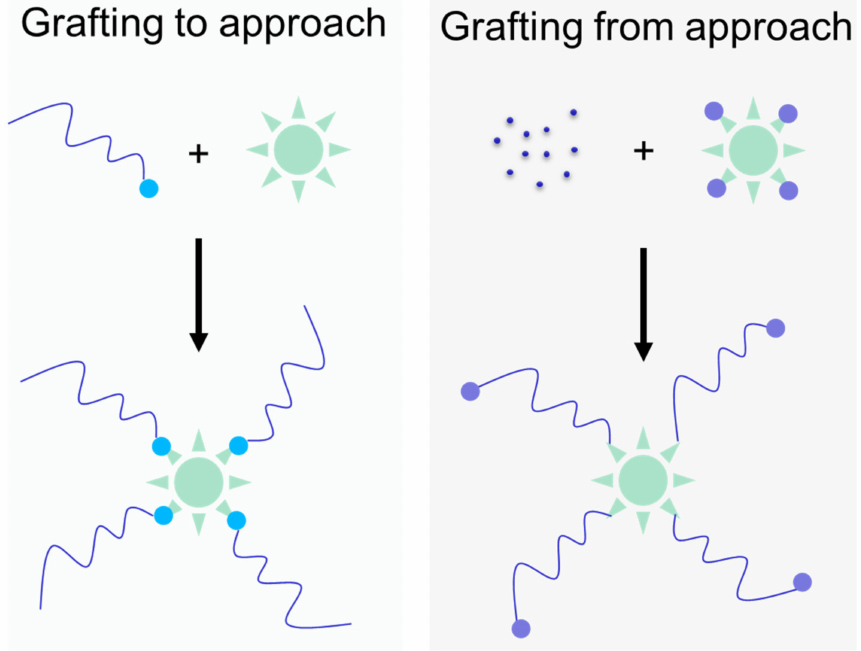
Figure 3. Schematic description of pHPMA-based star-like nanomedicine synthesis. The grafting-to approach is based on the covalent one-point attachment of semitelechelic polymer precursors (the light blue dot is reactive group on main chain end of polymer) onto the core (green star) containing functional groups. The grafting-from approach is employing the reversible addition–fragmentation transfer (RAFT) polymerization using the core containing several chain-transfer agents (violet dots) leading to the growth of the polymer chain from monomers (small violet dots) directly on the